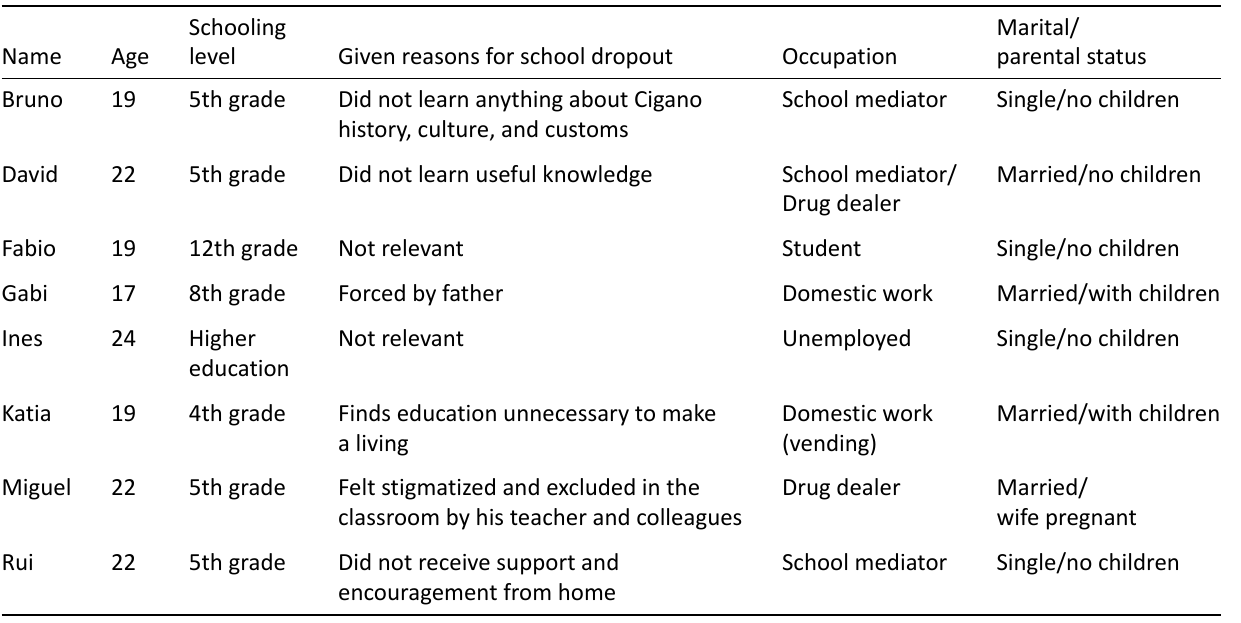
Table 1. Biographical overview of participants.